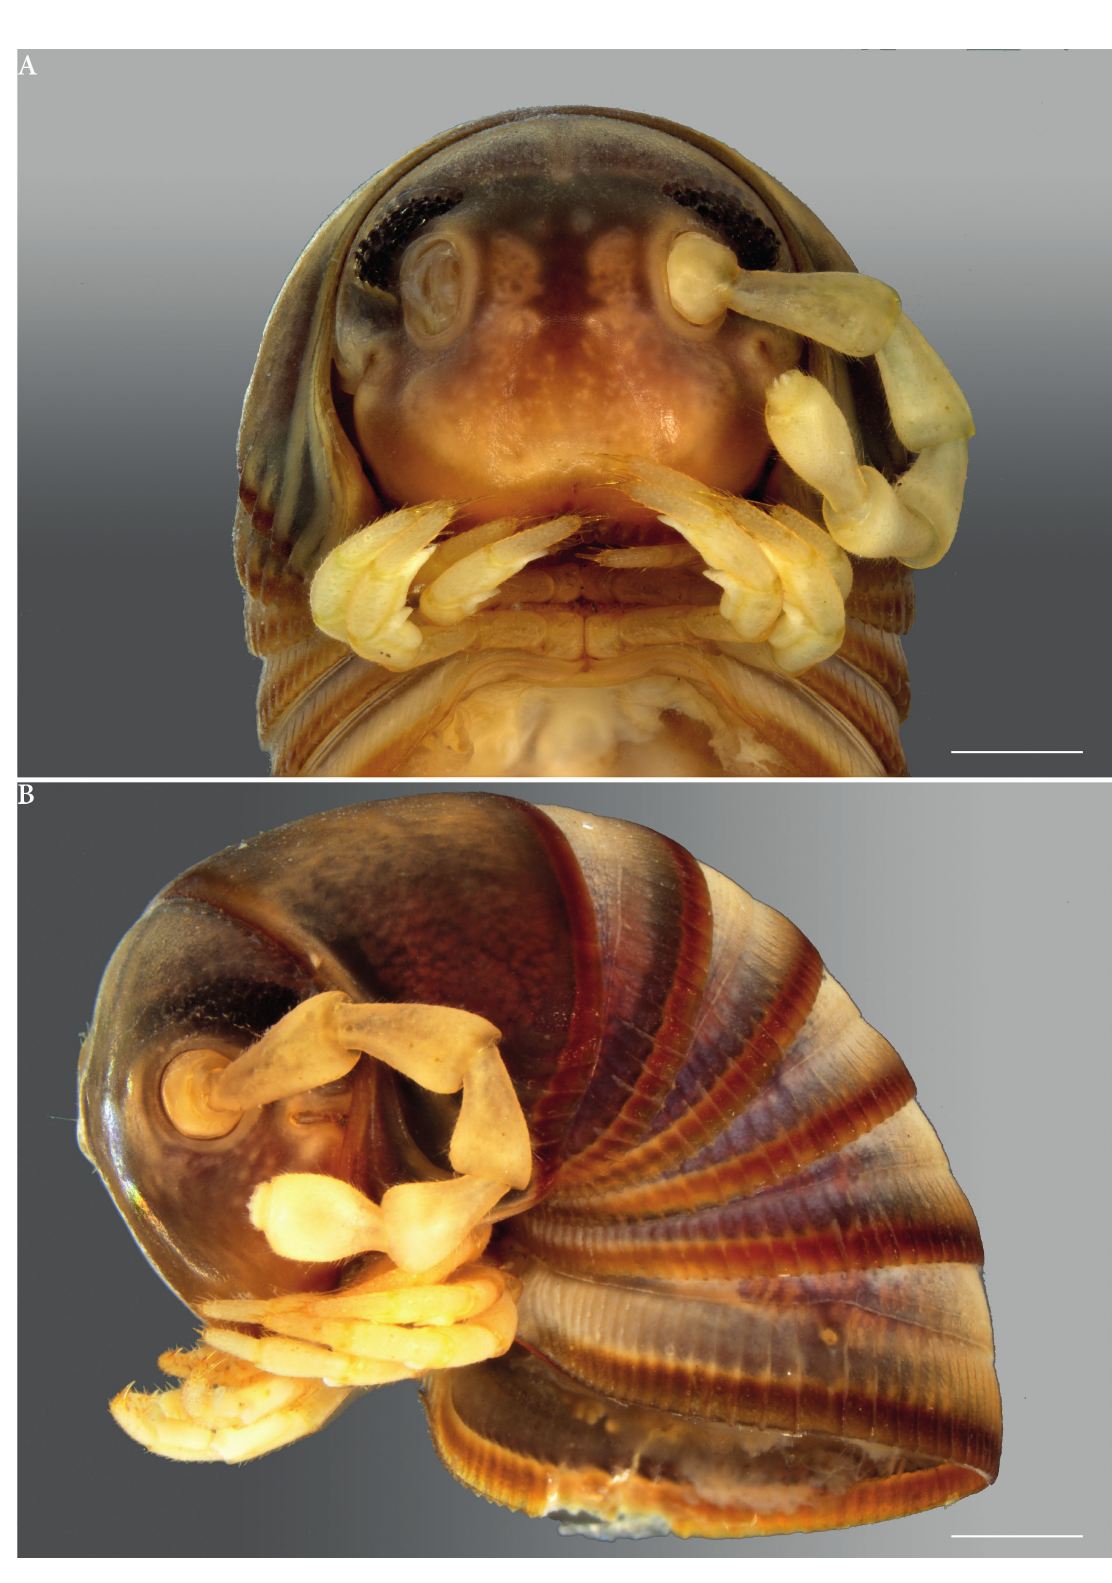
Fig. 2. Attemsostreptus reflexus sp. nov., male holotype (NHMD607065), head and anteriormost body rings. A . Ventral view. B . Lateral view. Scale bar: 1